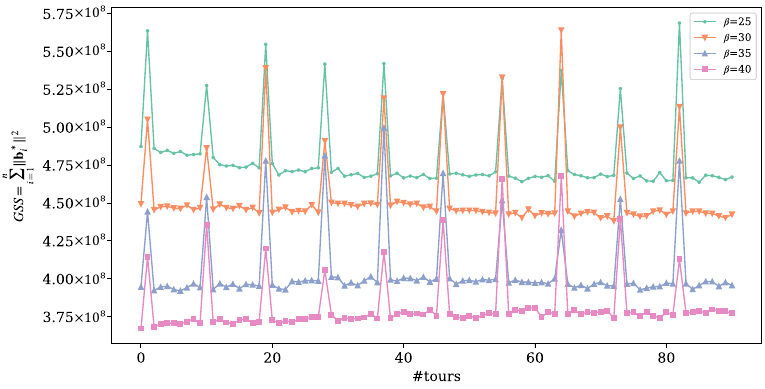
Figure 1. The Evolution of GSS ( B ) During reprocessing, n = 120, k = 8, β = 25,30,35,40. Geometry Series Assumption and GS